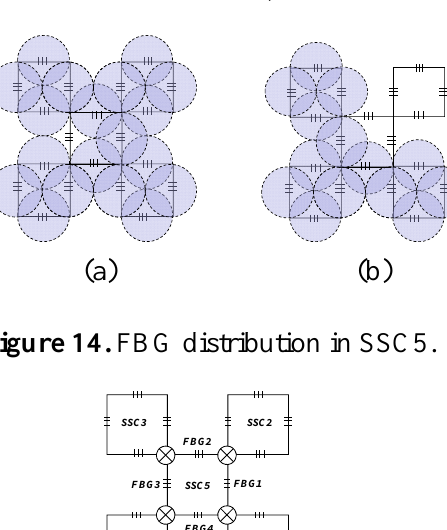
Figure 13. (a) Area loss in case 1; (b) Area loss in case 2.